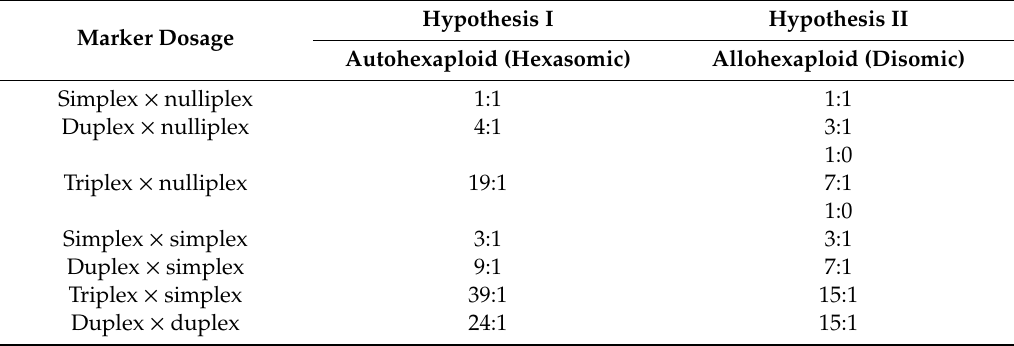
Table 5. Expected segregation ratios for the inheritance of a dominant marker in hexaploid chrysanthemum according to two cytological hypotheses (Park et al.